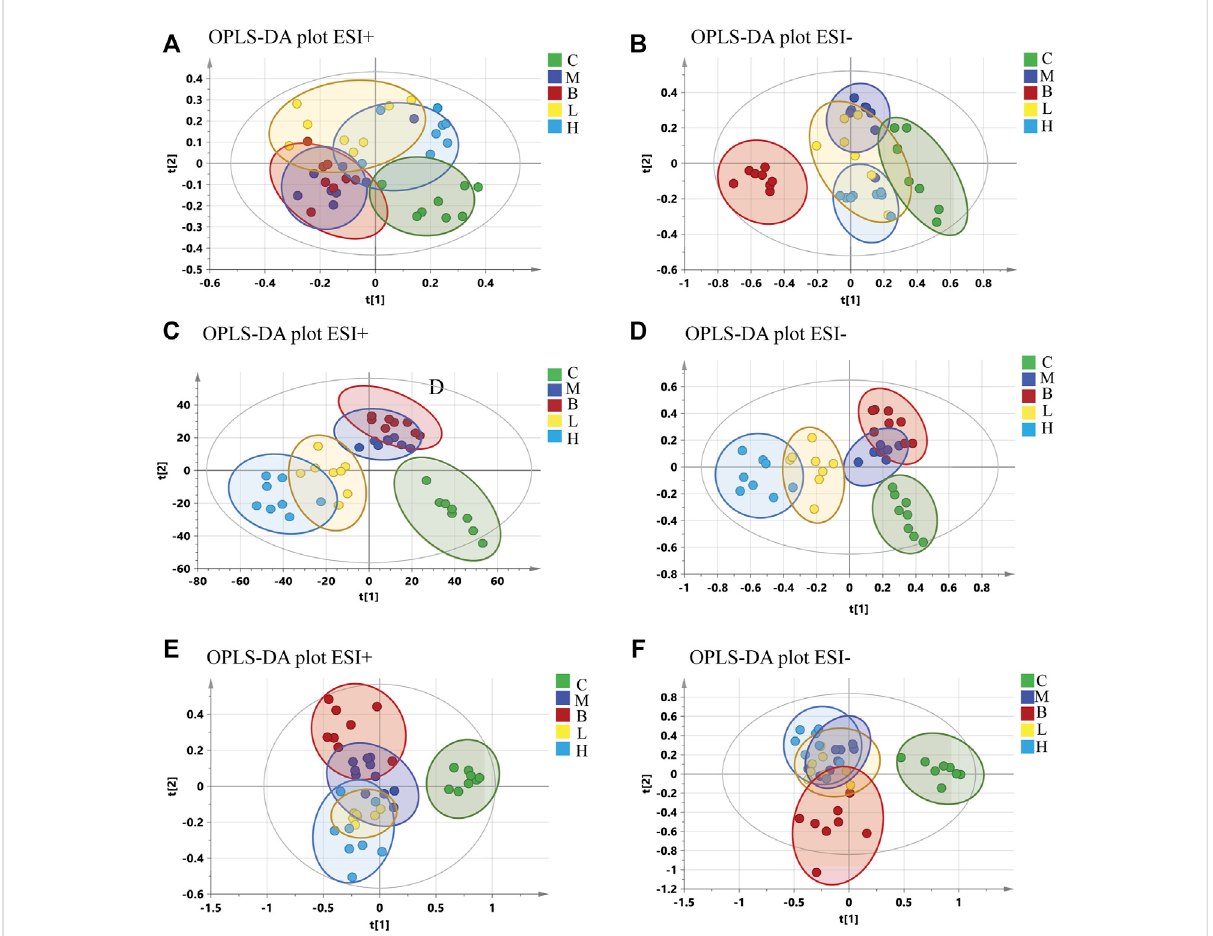
FIGURE 1 OPLS-DA of all samples in control group (C) , HUA model group (M), positive drug (benzbromarone) group (B), low-dose AMUP group (L), and high-dose AMUP group (H). (A) Score scatter plot of the blood samples in positive mode. (B) Score scatter plot of the blood samples in negative mode. (C) Scorescatterplotofthefecessamplesinpositivemode. (D) Scorescatterplotofthefecessamplesinnegativemode. (E) Scorescatterplot of the urine samples in positive mode. (F) Score scatter plot of the urine samples in negative